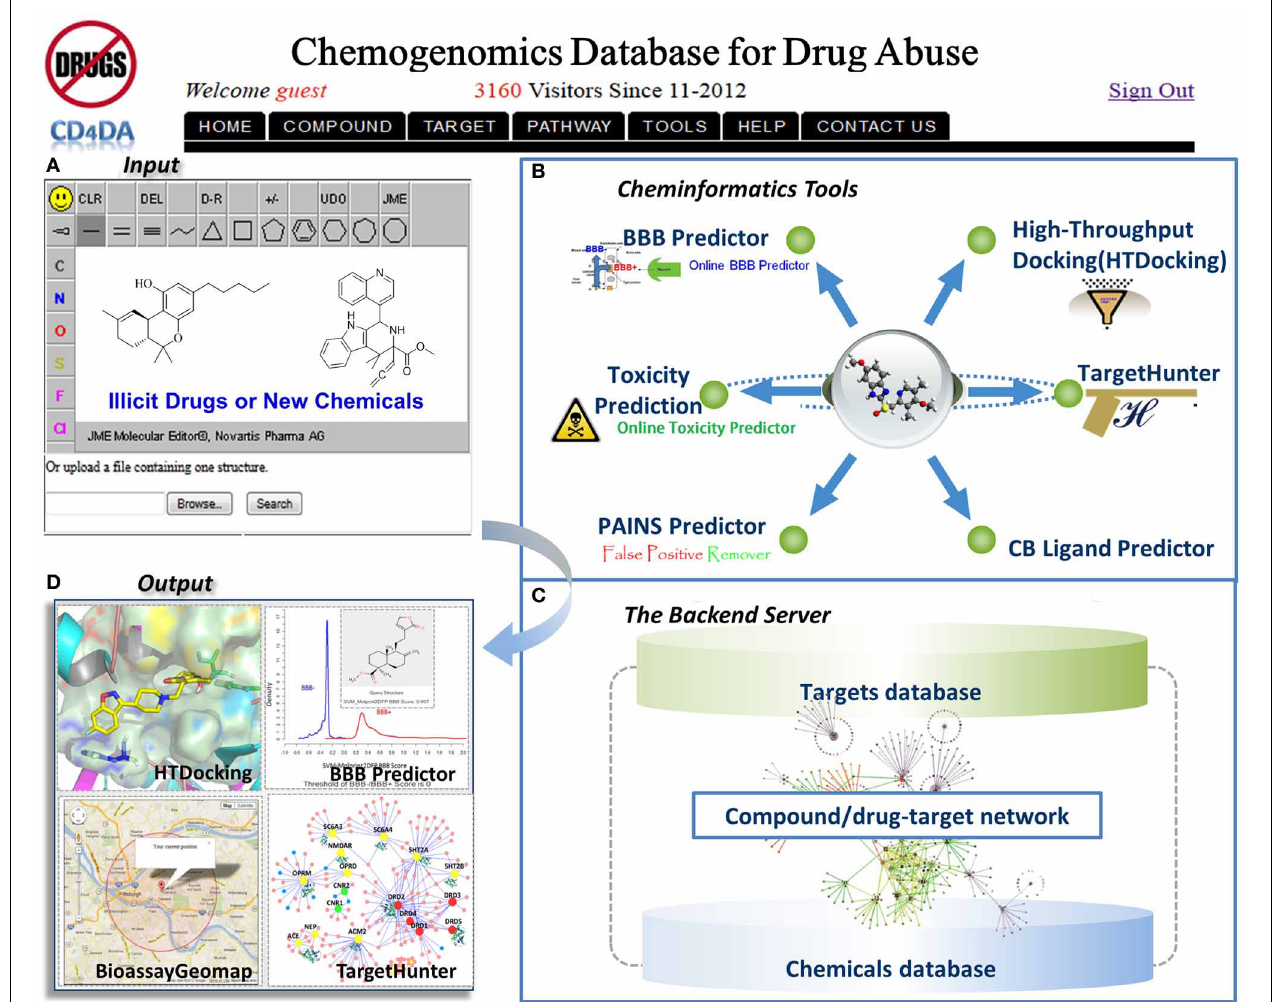
FIGURE 1 | The overview of our integrated DA domain-specific cloud computing and sourcing platform (CloudDA) with illustration of a friendly user-interfaced query (A) and output (B) and server backend (C) of the constructed computational chemogenomics database as